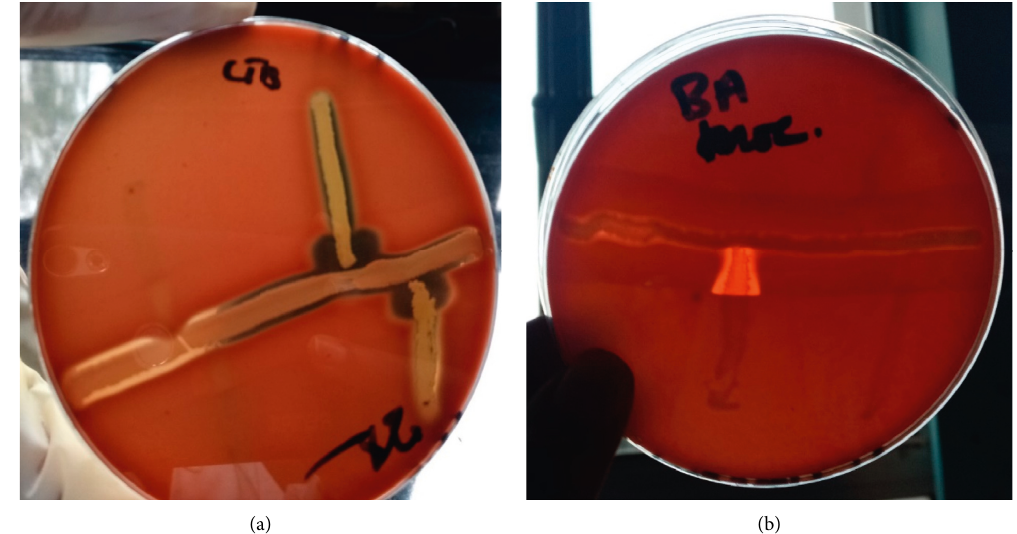
Figure 2: CAMP test results of the isolates against Staph . aureus where: (a) is the shovel shape of Listeria monocytogenes and (b) is the arrow shape of Strep . agalactiae.